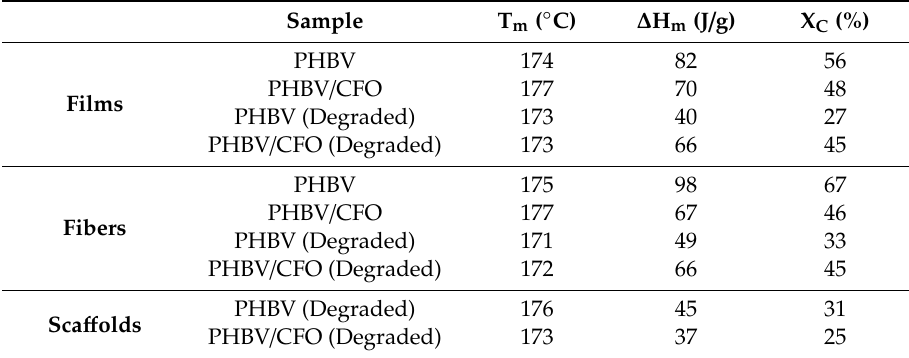
Table 1. T m , ∆ H m and X C of PHBV and PHBV / CFO composite non-degraded [8] and degraded samples. The associated error is ± Table 1. T m , ΔH m and X C of PHBV and PHBV/CFO composite non-degraded [8] and degraded samples. The associated error is ±2%.